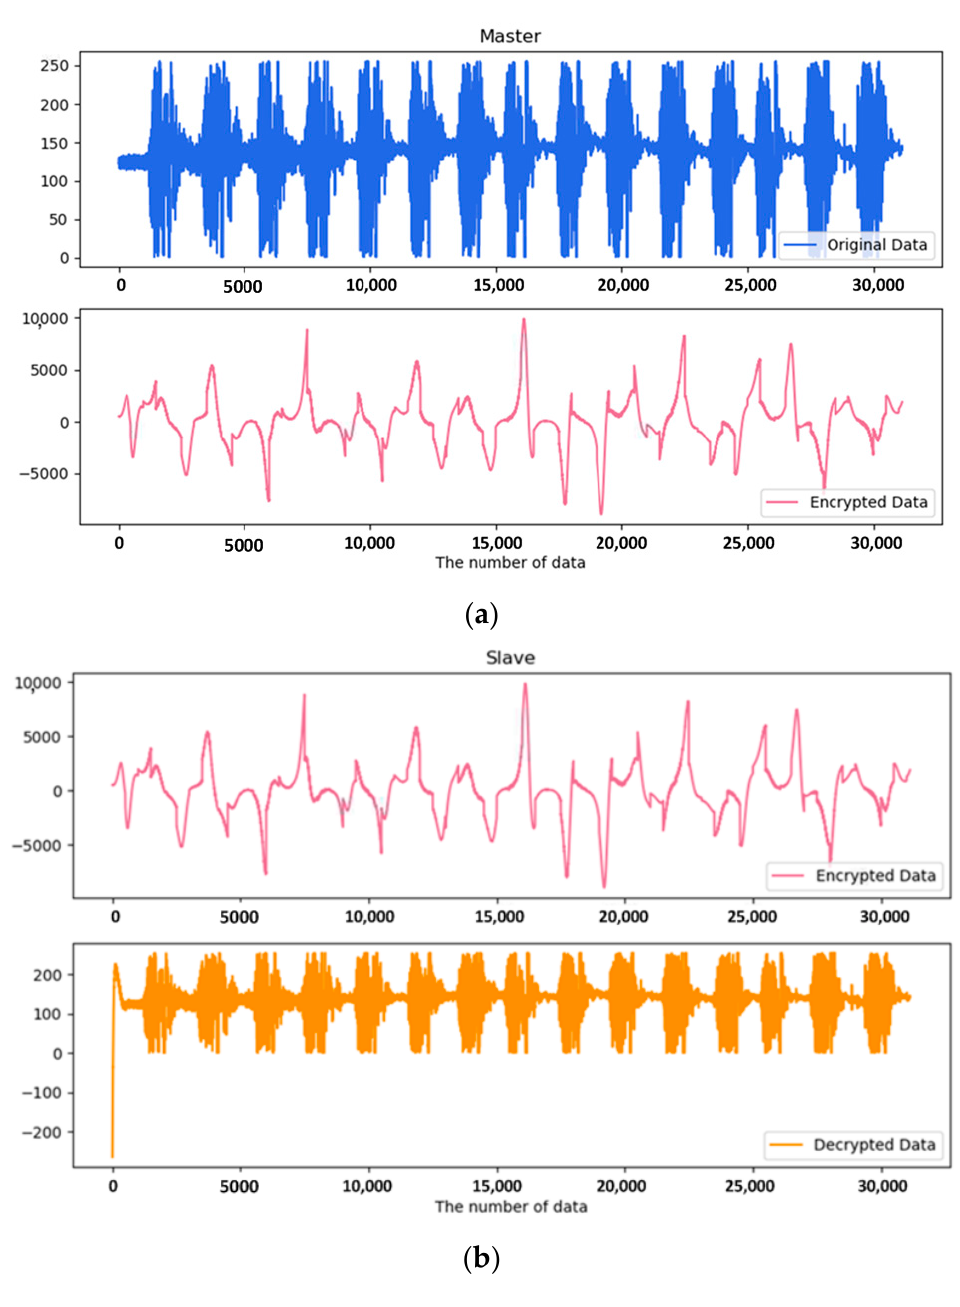
Figure 21. Implementation of EMG with Raspberry Pi (RPi). ( a ) The data in the Master; ( b ) The data in the Slave.